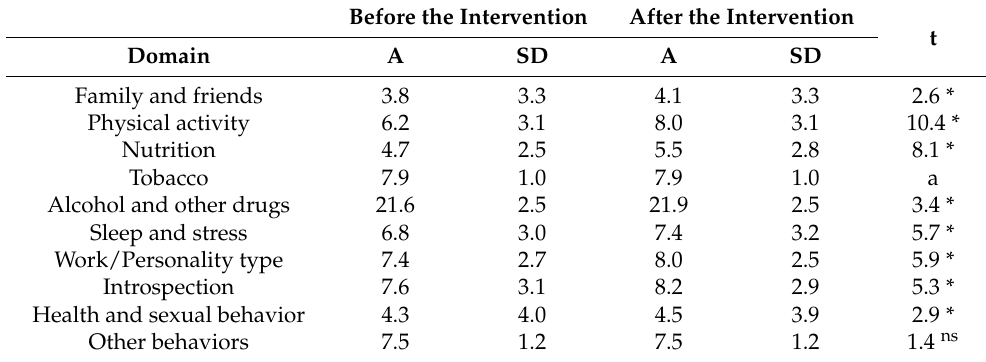
Table 3. Domains of the Fantastic Lifestyle questionnaire before and after the intervention.